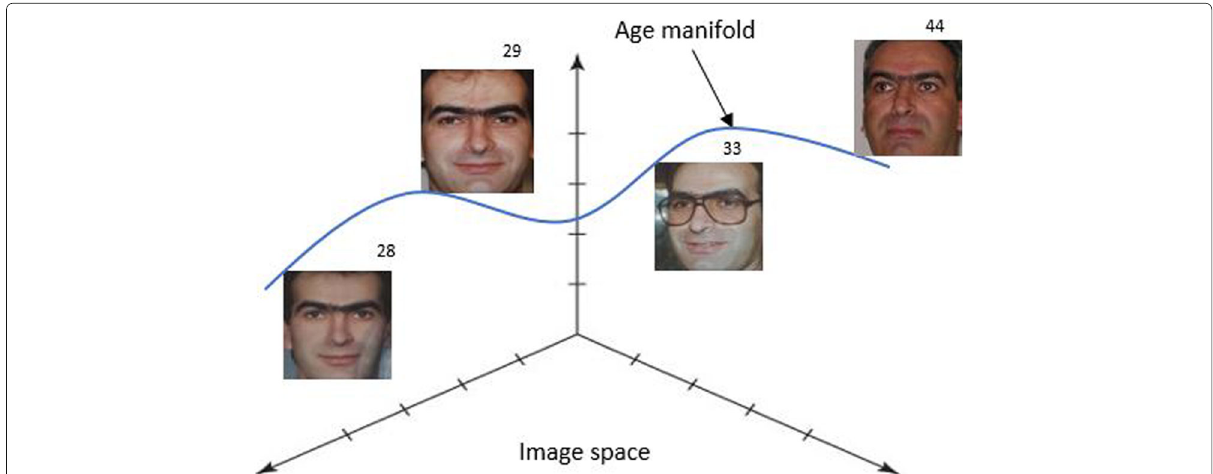
Fig. 6 Simple nonlinear age